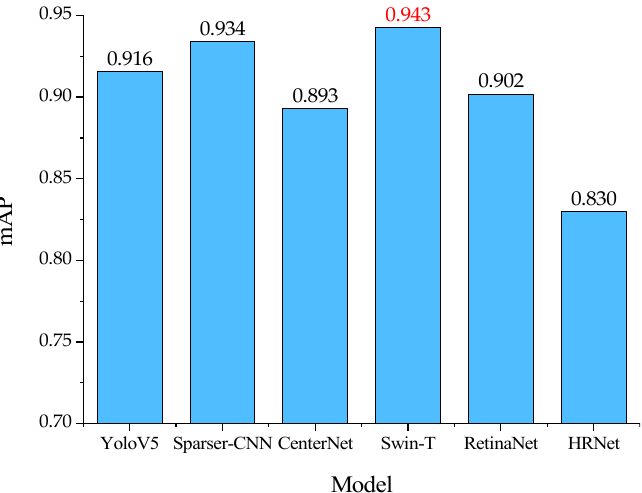
Figure 17. Comparison of mAP value by the proposed model and other models for the validation set.